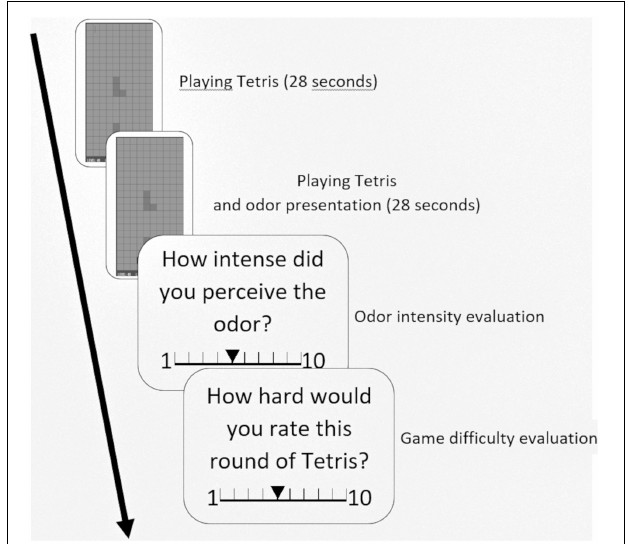
FIGURE 2 | Flow-chart of the experiment. The subjects first played Tetris for 28 s, then the odor was presented while they kept playing Tetris for another 28 s. Then the subjects were asked to rate the intensity of the odor and the game difficulty on a scale from 1 to 10.